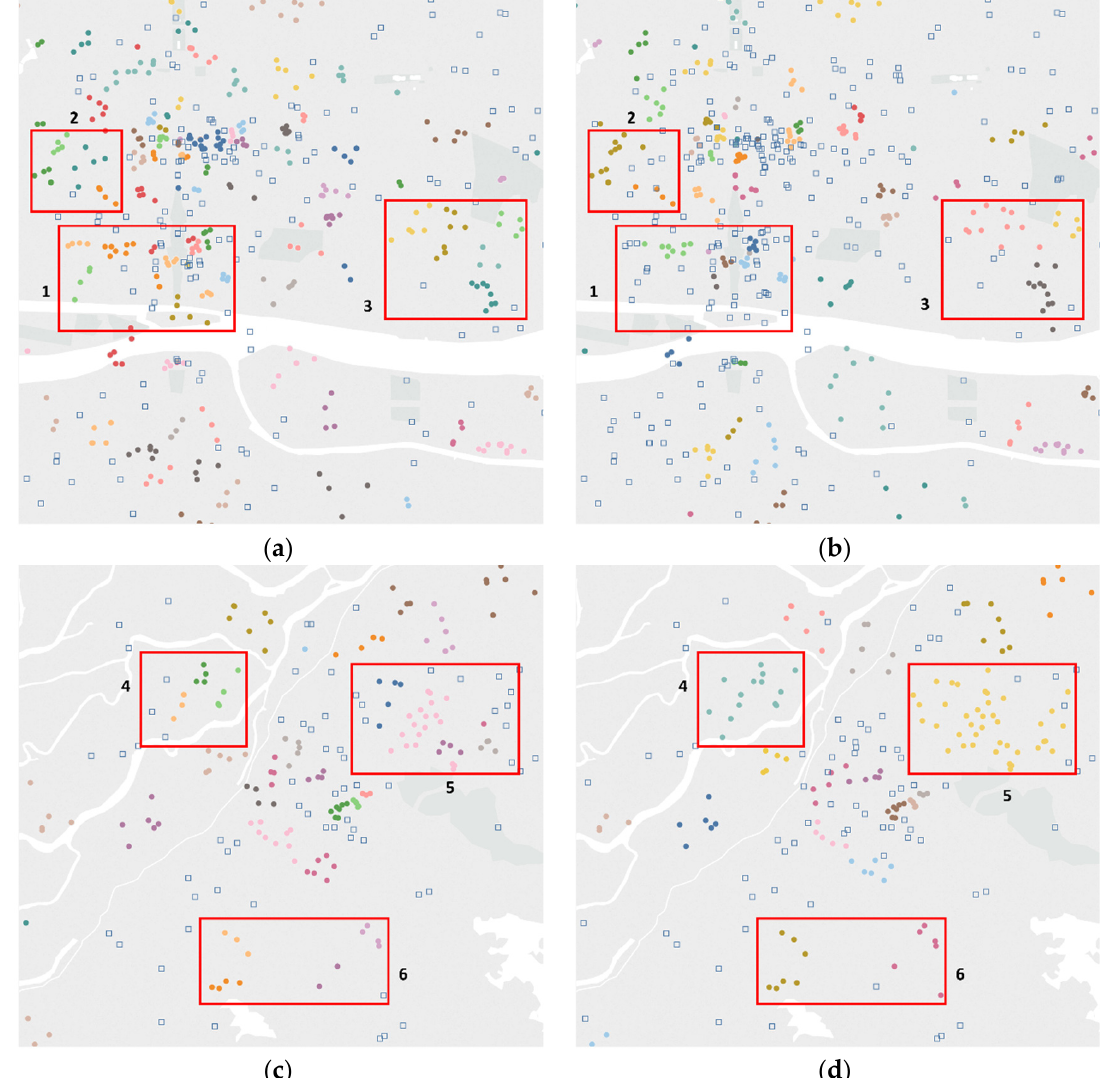
Figure 11. Visual comparison of ELV and HDBSCAN in two areas with different densities based on the first day data of the GBA dataset: ( a ) clustering result of ELV in a high-density area, ( b ) clustering result of HDBSCAN 4 in a high-density area, ( c ) clustering result of ELV in a low-density area, and ( d ) clustering result of HDBSCAN 4 in a low-density area. Additionally, solid circles represent clustered points and hollow squares are noise points.